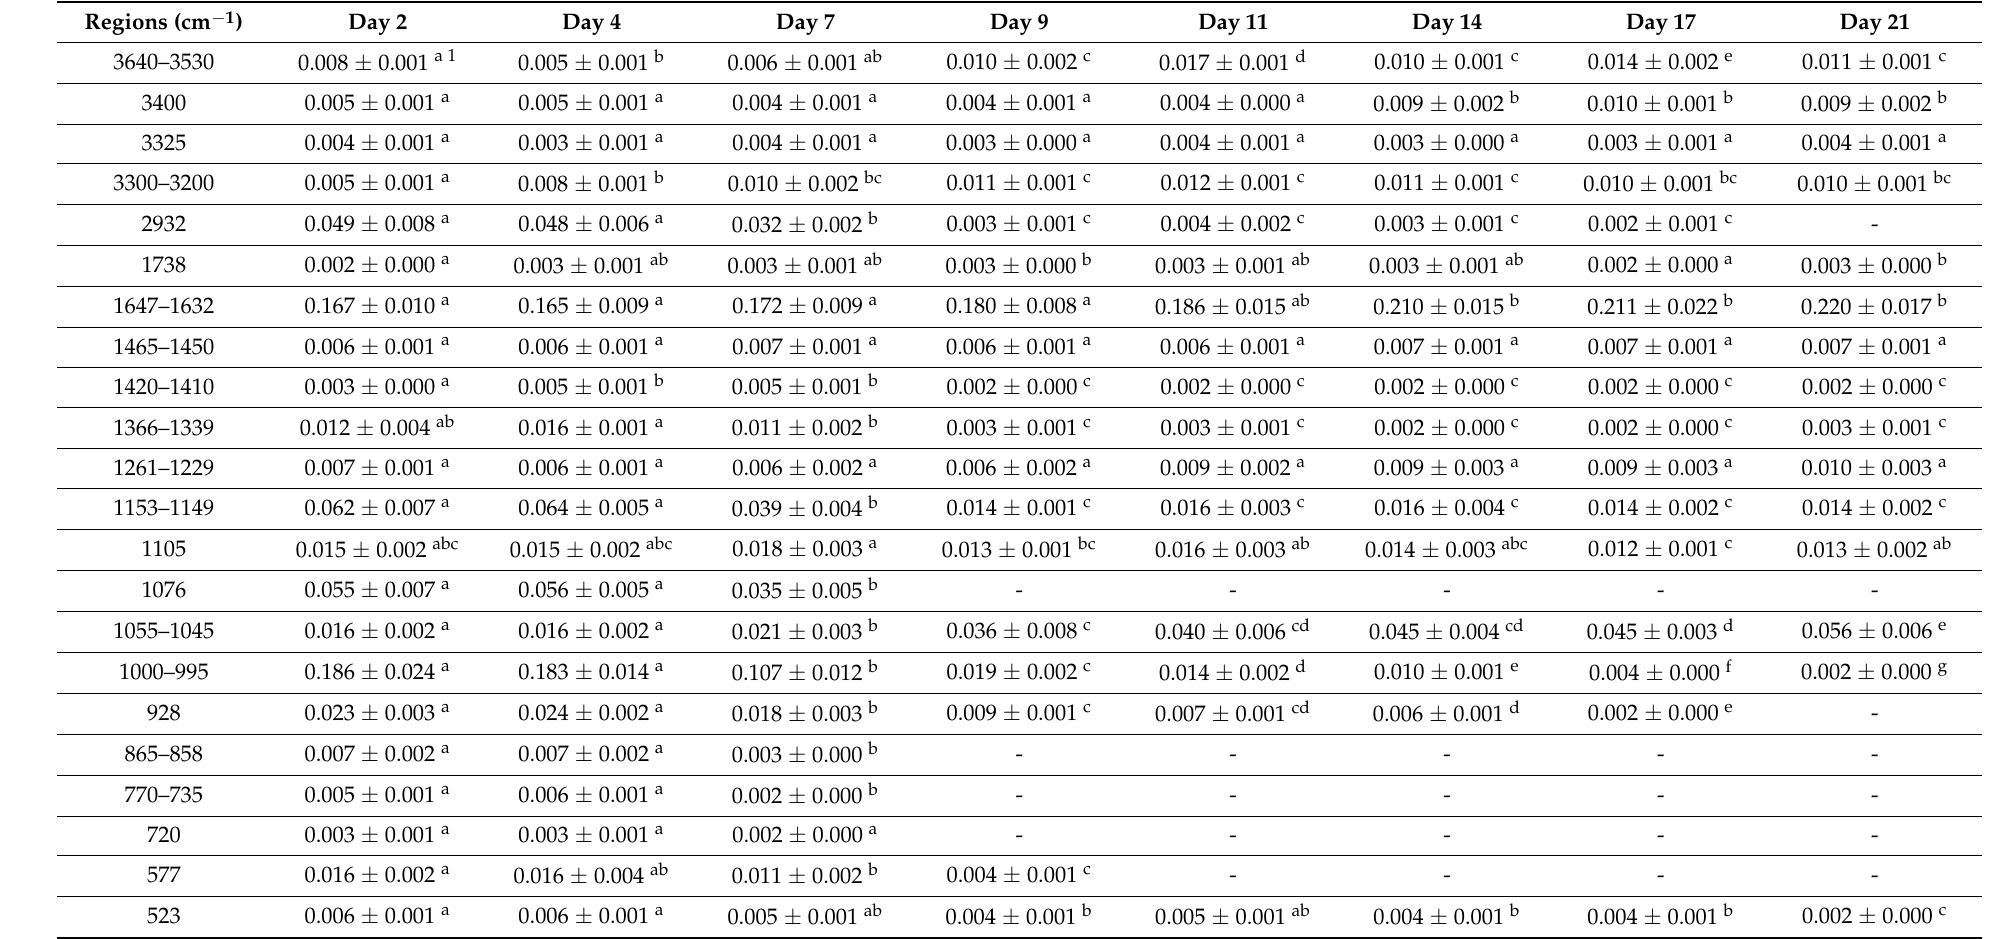
Table 2. The spectral absorbance bands (intensities) of the banana flesh at different days of